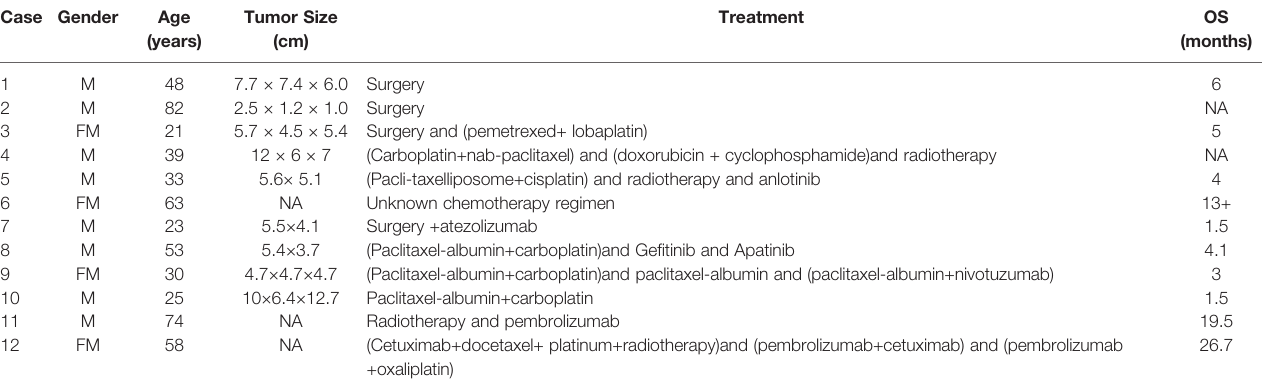
TABLE 2 | Summary of case reports of NUT cancer in recent